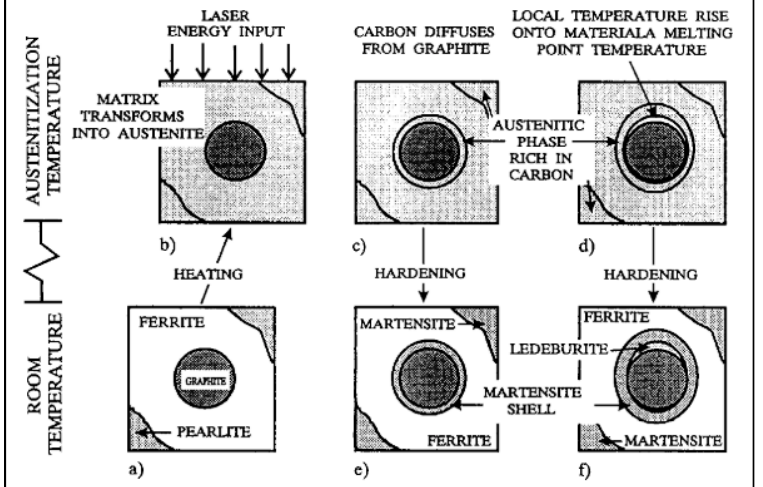
Figure 13. Schematic representation of phase changes around graphite nodules during LSM: ( a ) Initial DI microstructure, ( b ) transformation to nonhomogeneous austenite during heating, ( c ) carbon en- richment in austenitic matrix after diffusion, ( d ) local melting around graphite nodules, ( e ) formation of martensitic shells around graphite nodules after cooling, ( f ) formation of ledeburitic shells above graphite nodules that suffered local melting (Reprinted with permission from ref. [63]. 1996 Elsevier).